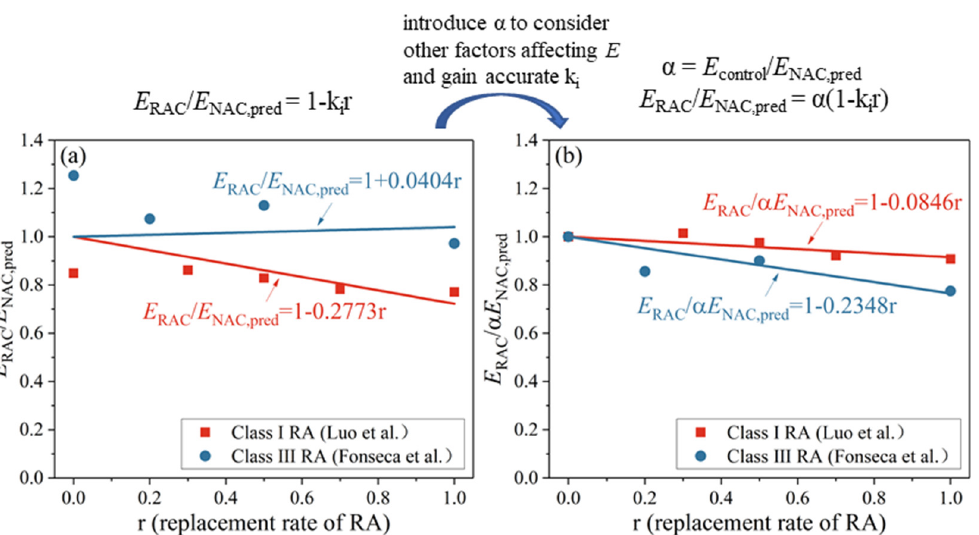
Figure 1. Introducing α to consider other factors affecting E (data source: Luo et al. [21]; Fonseca et al. [22]). ( a ) E RAC / E NAC,pred ; ( b ) E RAC / α E NAC,pred . et al. [22]). ( a ) E RAC / E NAC,pred ; ( b ) E RAC / α E NAC,pred